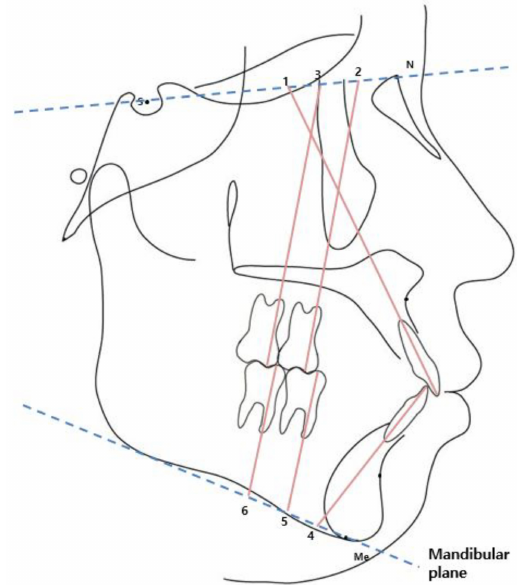
Figure 5. Cephalometric dental angular measurements. In maxilla: 1, SN to upper incisor; 2, SN to upper first molar; 3, SN to upper second molar. In mandible: 4, MP to lower incisor; 5, MP to lower first molar; 6, MP to lower second molar.